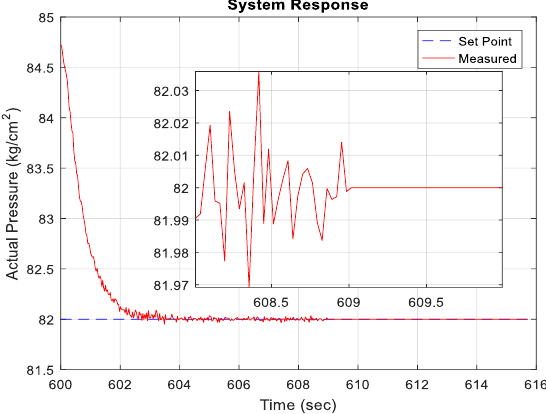
Fig. 16. Steam pressure compensation with relief